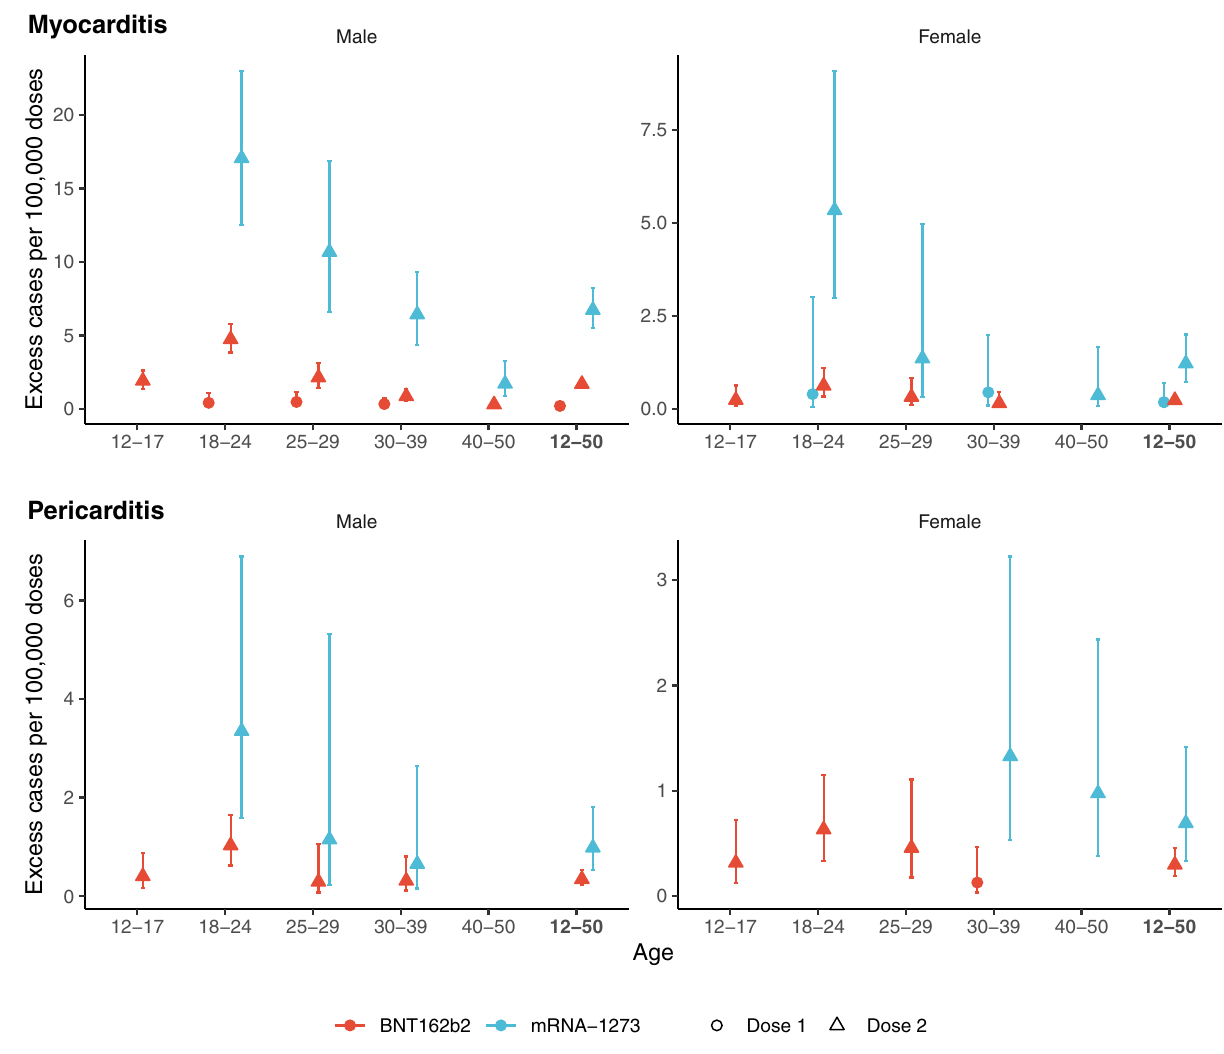
Fig. 3 Excess cases of myocarditis and pericarditis attributable to mRNA vaccines according to sex and age group, per 100,000 doses. Excess cases are based on the risk in the 7 days following vaccination. Colors denote the type of vaccine and the shape of point estimate denotes the ranking of dose vaccine. Centre value are excess cases point estimates and error bars represent 95% con fi dence intervals. Number of cases (N) by age categories (12 – 17, 18 – 24, 25 – 29, 30 – 39, 40 – 50 and 12 – 50 years) are respectively as follows: for cases of myocarditis, N = 137, 480, 210, 273, 181 and 1281 in males, and N = 29, 106, 40, 88, 68 and 331 in females; for cases of pericarditis, N = 65, 194, 106, 282, 342 and 989 in males, and N = 36, 118, 91, 183, 196 and 624 in females. Excess cases was only calculated in categories with a signi fi cantly positive association between the vaccine exposure and the outcome (adjusted odds-ratio